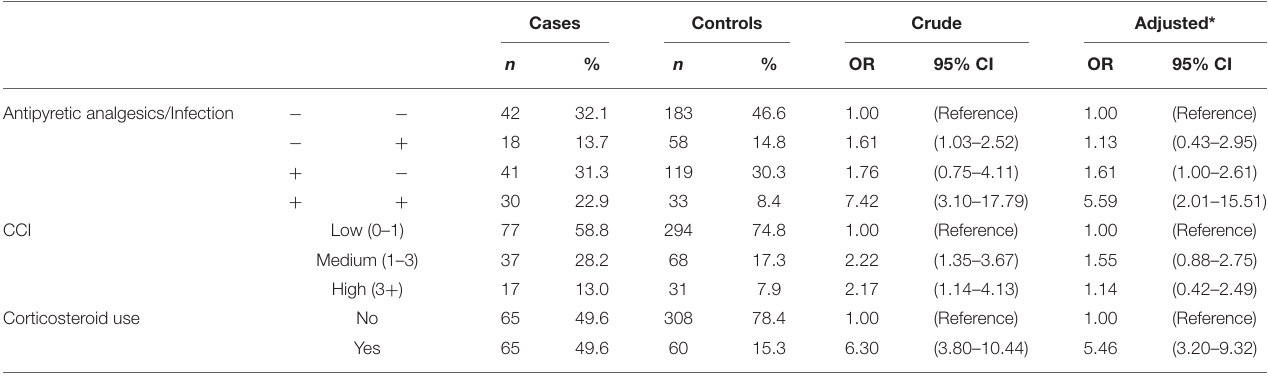
TABLE 1 | Odds ratios for the combination between antipyretic analgesics and infection in matched nested case control analysis of SJS/TEN. Cases Controls